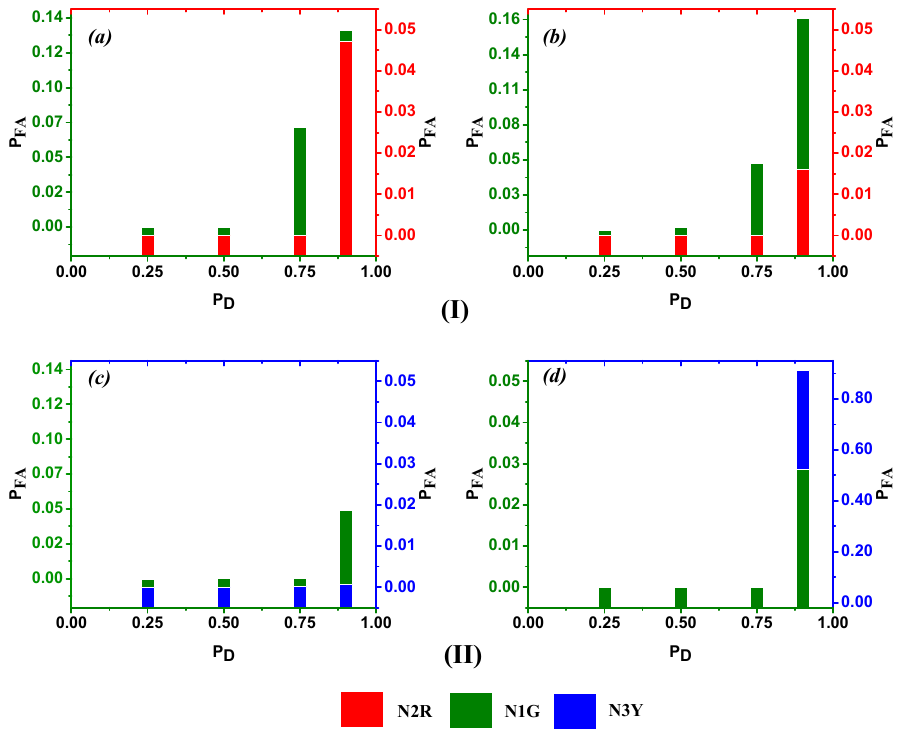
Figure 20. False alarms at di ff erent levels of P D for (I) identical target material (N1G and N2R) in the same context (vegetative) for the ( a ) best case, and ( b ) worst-case detection performance; (II) identical target material (N1G and N3Y) in a di ff erent context (vegetation and soil respectively) for ( c ) best case, and ( d ) worst-case detection performance.